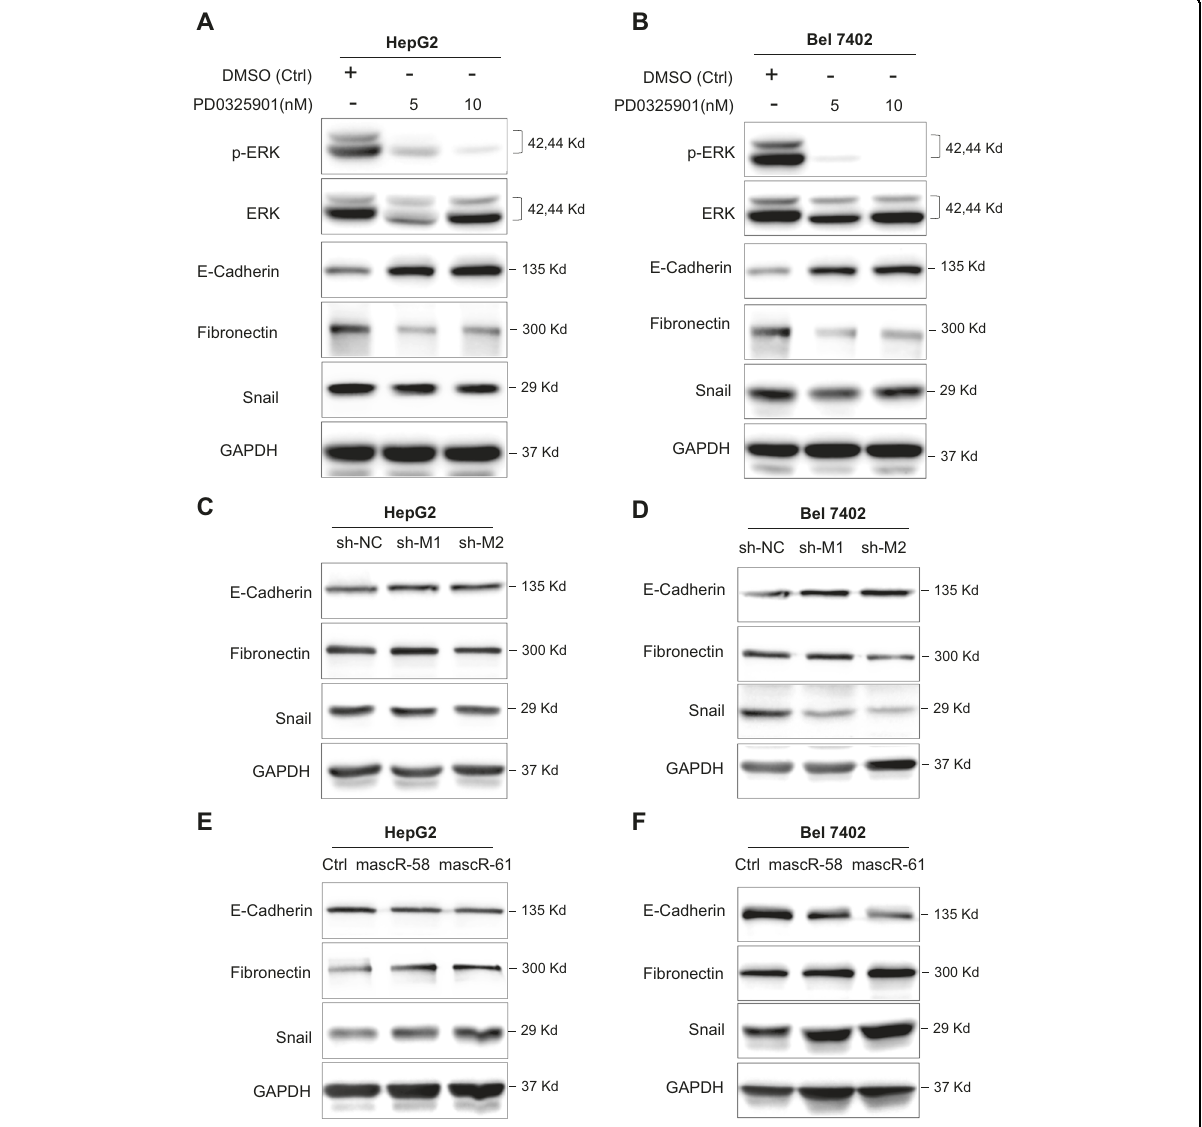
Fig. 7 mascRNA and MALAT1 regulate metastasis genes through ERK/MAPK signaling. Western blotting for p-ERK, ERK, E-Cadherin, Fibronectin, Snail in ( A ) HepG2 and ( B ) Bel7402 cells treated with DMSO or 5/10 nM PD0325901. Western blotting for E-Cadherin, Fibronectin, Snail in ( C ) HepG2 and ( D ) Bel7402 control and shMALAT1 stable cells. Western blotting for E-Cadherin, Fibronectin, Snail in ( E ) HepG2 and ( F ) Bel7402 control and mascRNA overexpressed stable cells. GAPDH was used as